Question: What kind of plot is shown here?
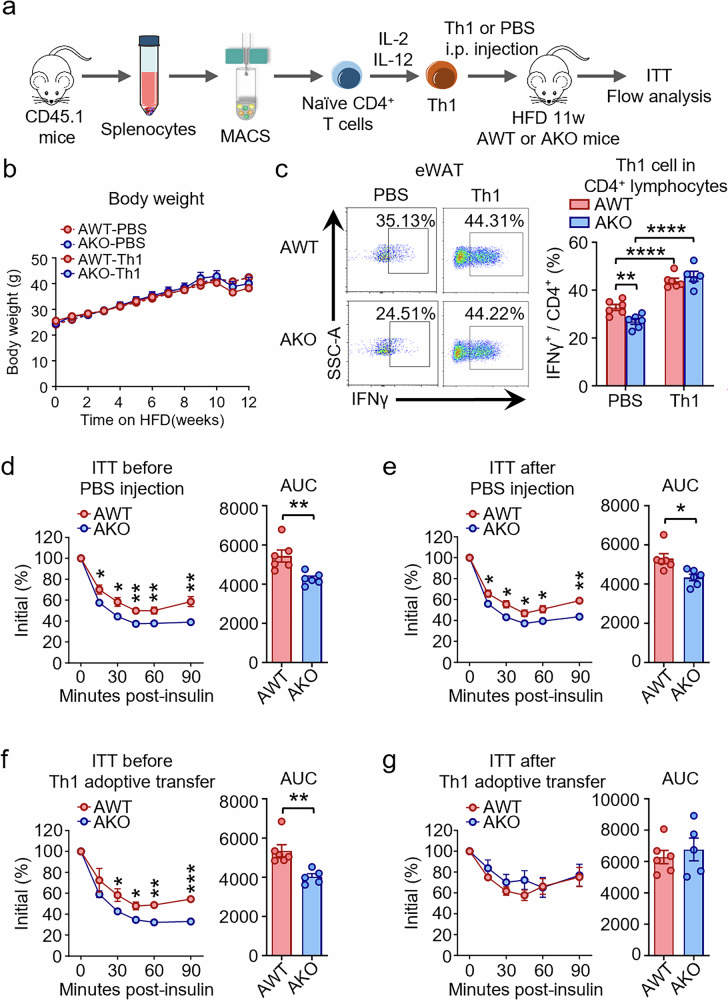
Answer: line